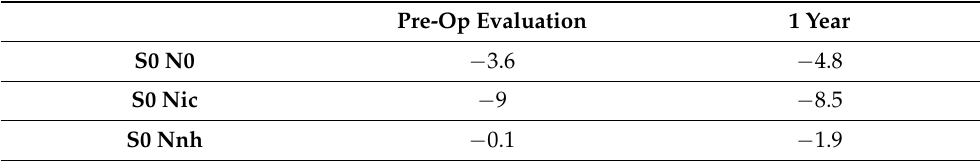
Figure 2. Clinical Case 2: 3 Tesla MRI with gadolinium showing a nodular enhancement, 2.7 mm in diameter, located on the right cochlear basal turn originating from the modiolus. Table 1. Clinical Case 2: Italian Matrix Sentence Test SNR scores at the pre-operatory evaluation and one year after cochlear implant. S0 refers to sound coming from a source in front of the patient, Nic to noise coming from 90 ◦ on the implanted side, and Nnh to noise coming from 90 ◦ on the normal hearing